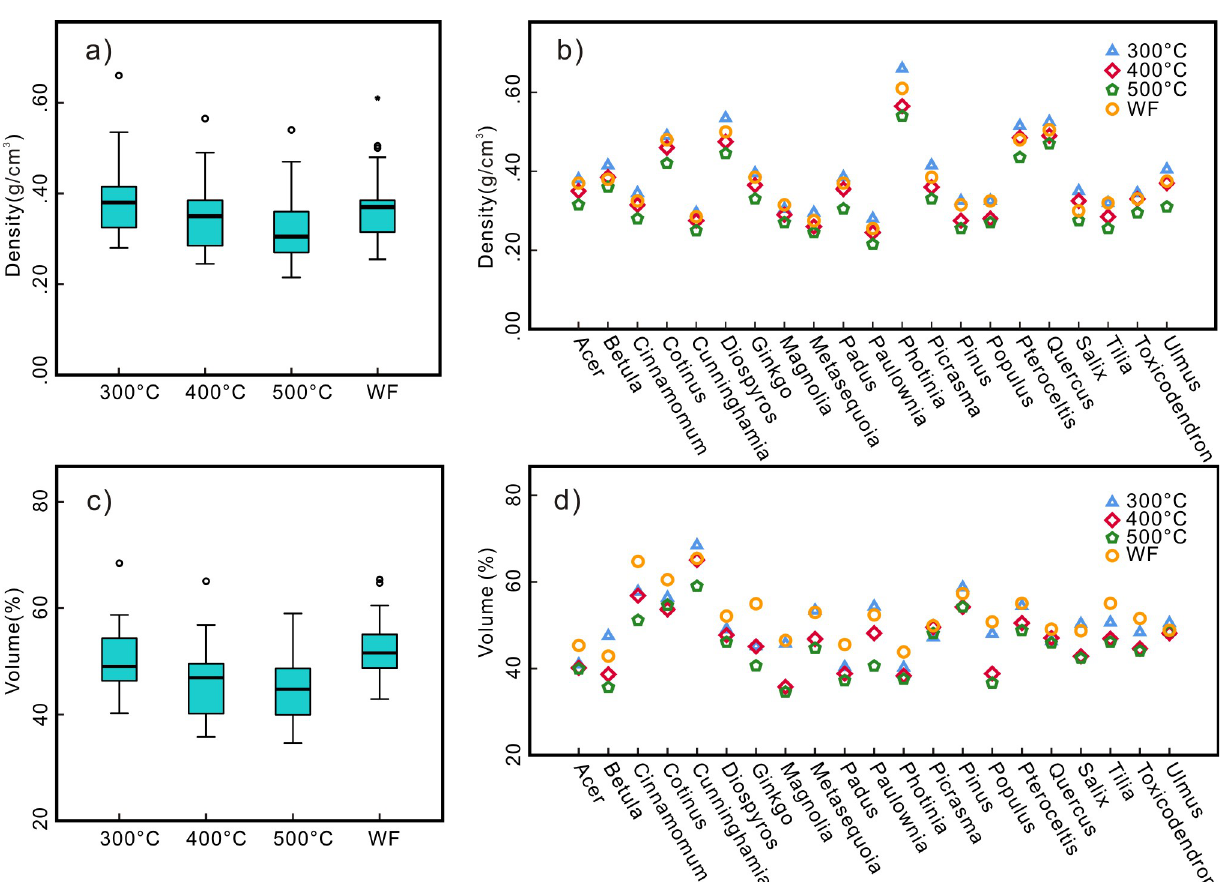
Fig 3. Charcoal density after carbonization (a) different temperatures; (b) different taxa; Volume loss after carbonization (c) different temperatures; (d) different